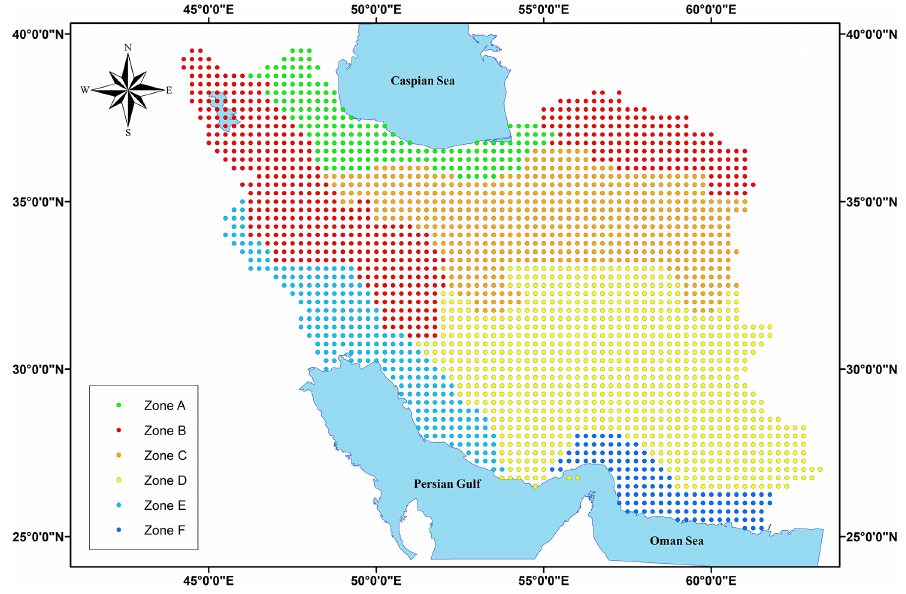
Figure 5. Dew formation zones based on the cluster analysis of the daily cumulative dew yield during 1979–2018.